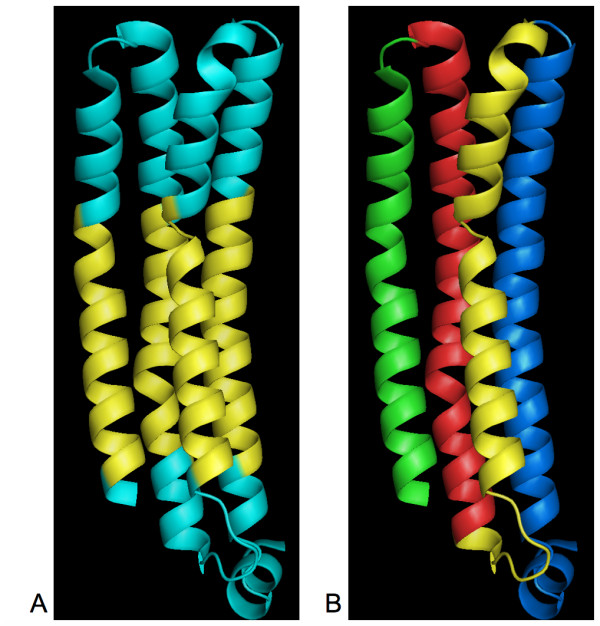
Structure of the rotor ring of the V-type Na-ATPase[15]. A: Embedded amino acids are in yellow (limits predicted by PDBTM). B: Each G2-HPulse is represented by a different color.